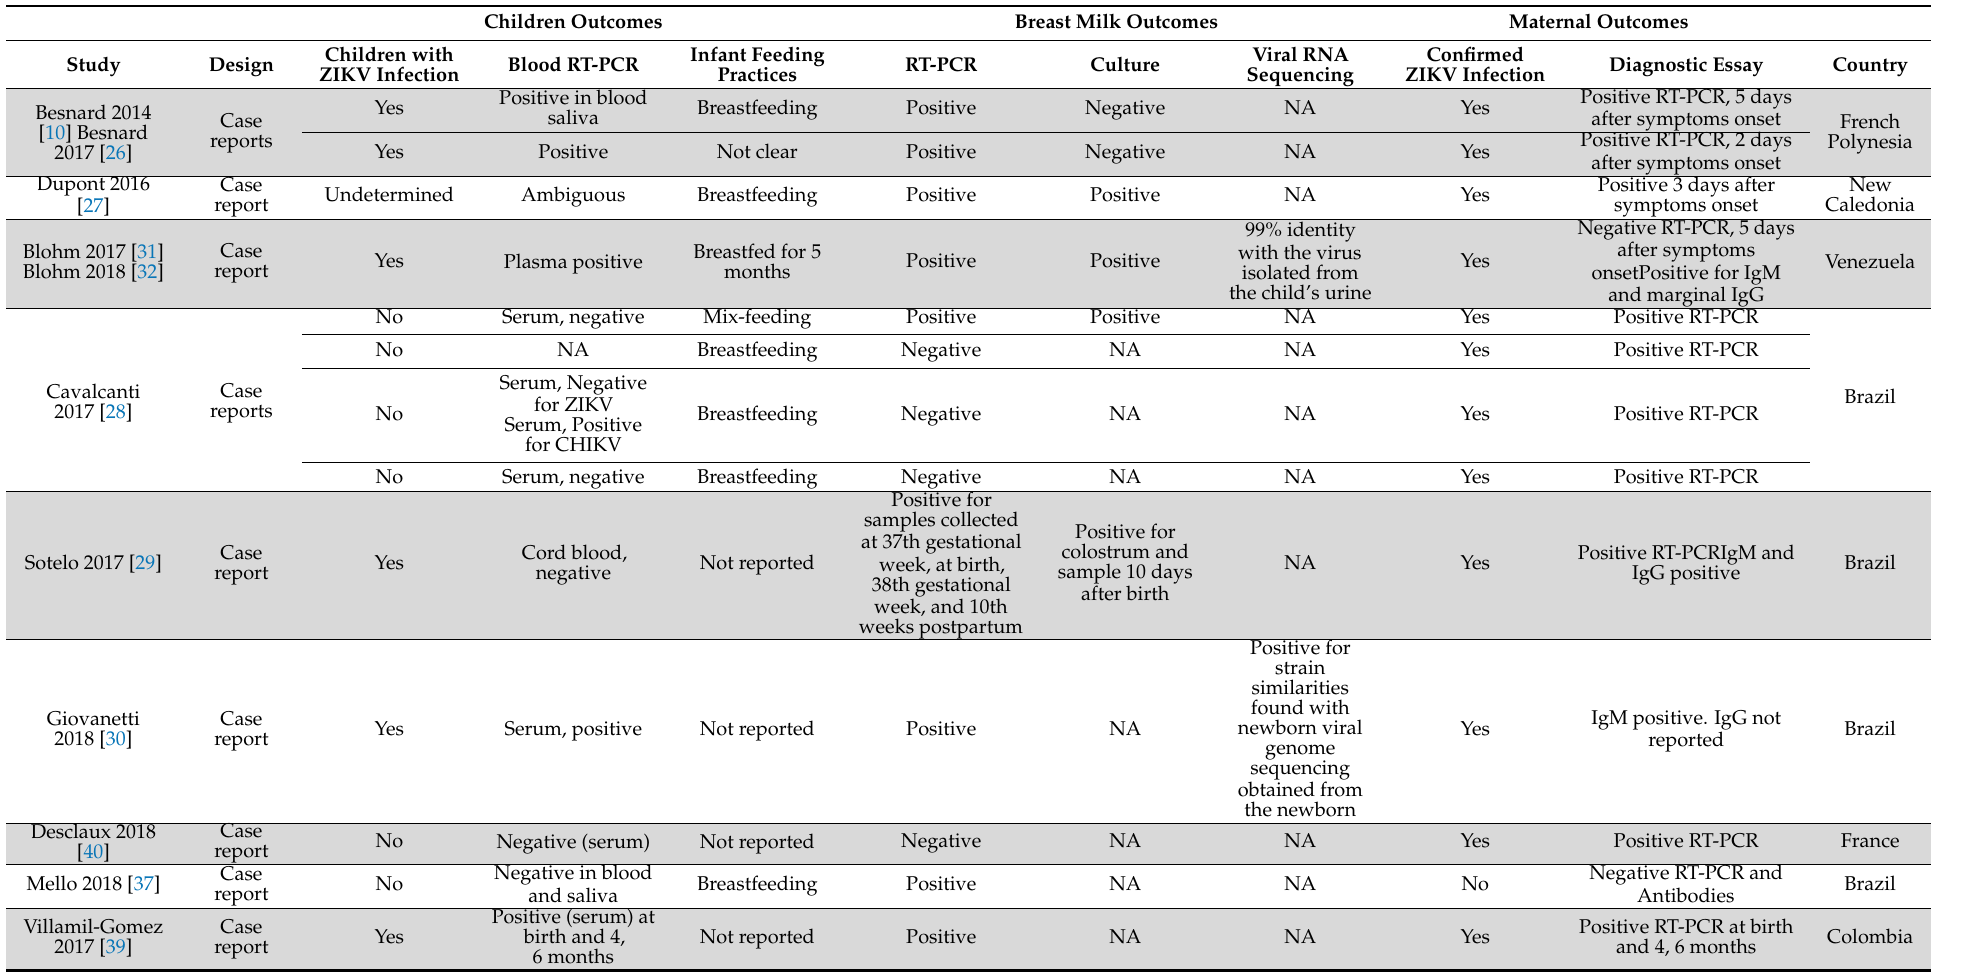
Table 1. Characteristics of mother and infant pairs included in the narrative